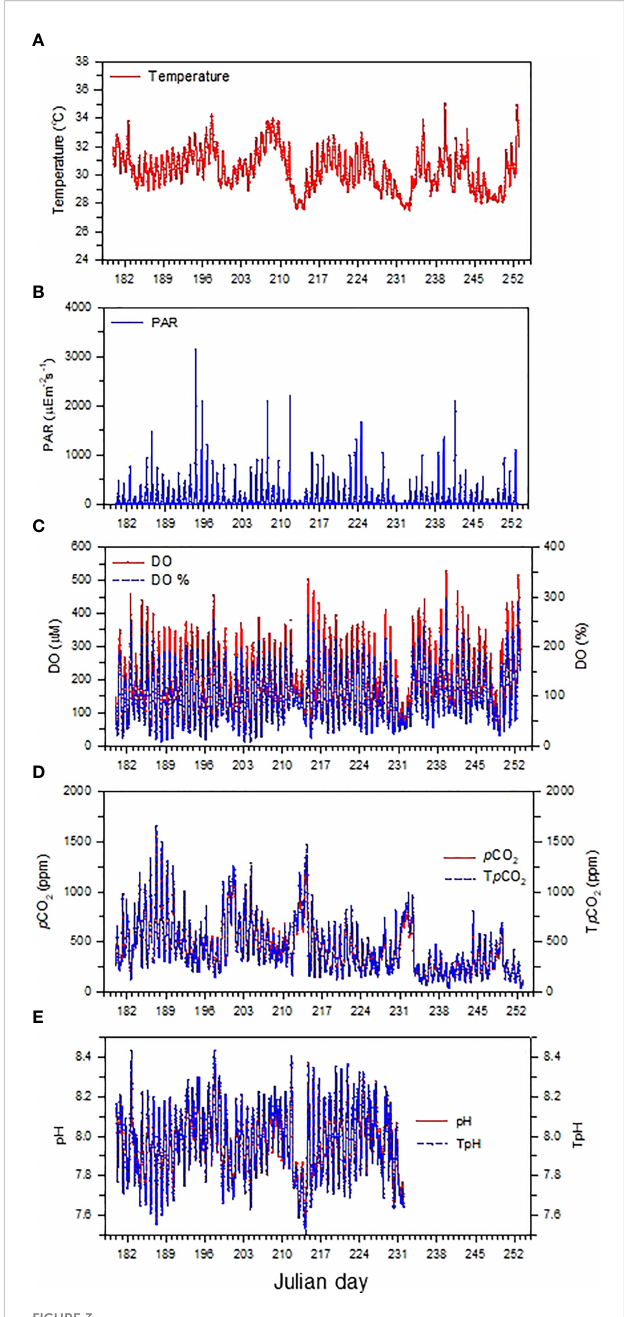
FIGURE 3 Time-series variations in (A) temperature, (B) PAR, (C) DO and DO saturation level (DO%), (D) p CO 2 (red solid line) and temperature normalized p CO 2 (T p CO 2 , blue dashed line), and (E) pH (red solid line) and temperature normalized pH (TpH, blue dashed line). T p CO 2 and TpH were normalized to a constant temperature of 30.4 °C, the average temperature during the study